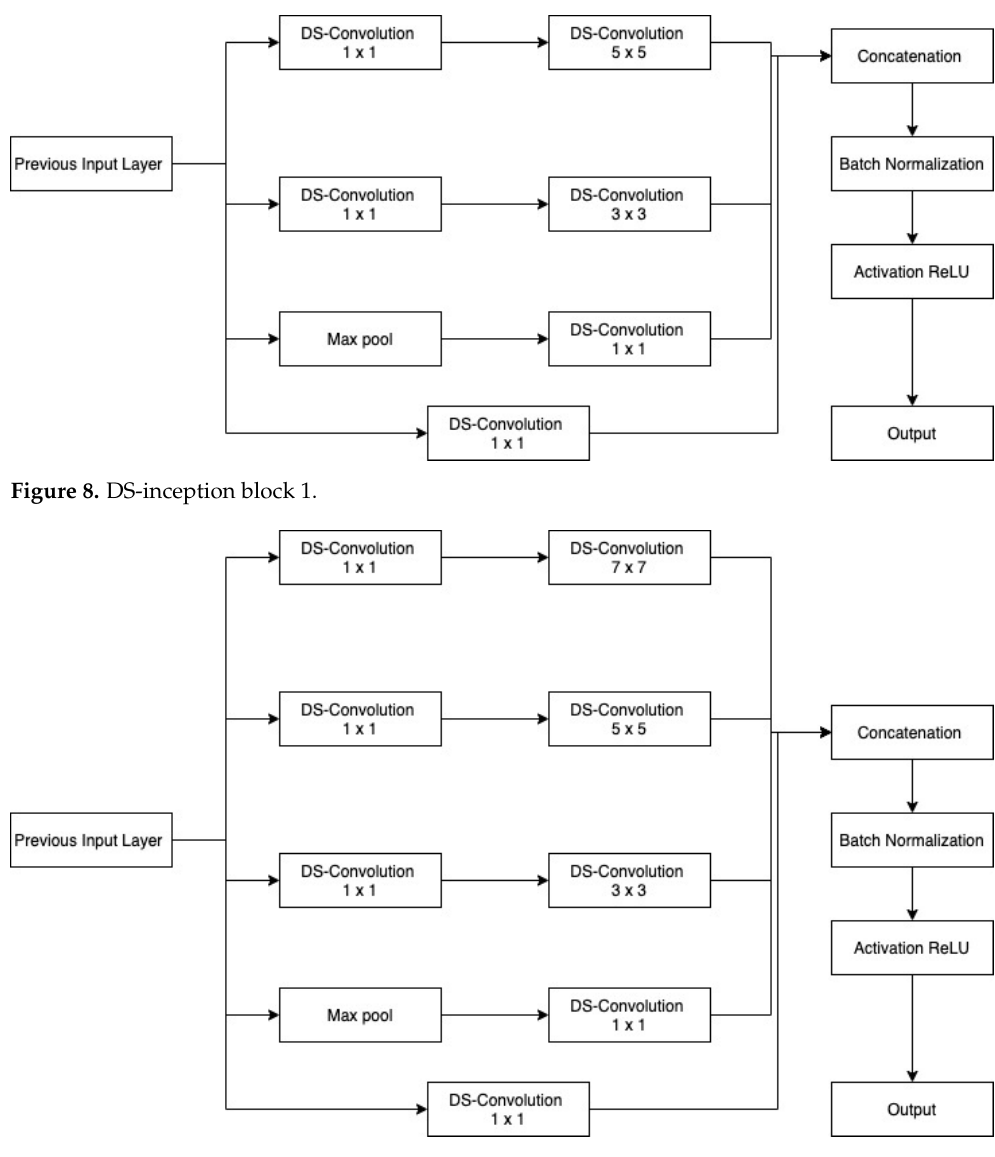
Figure 9. DS-inception block